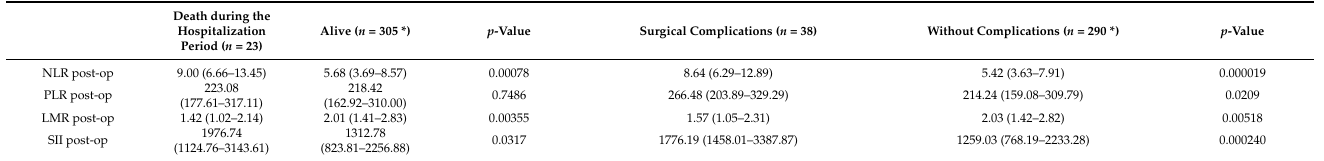
Table 7. The association of inflammatory ratios on the 4th and 5th follow-up day with post-operative complications (death during the hospitalization period and surgical complications) ( n = 328) *.